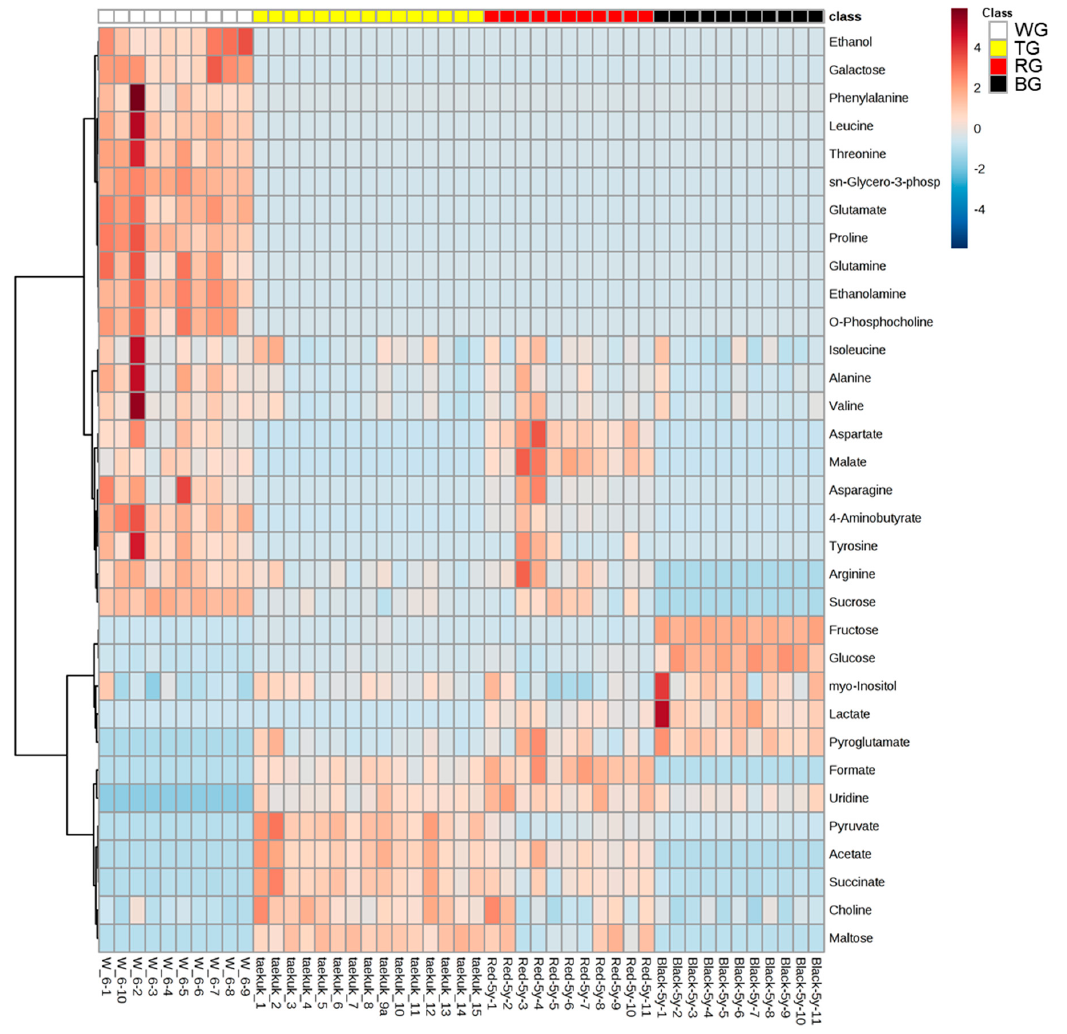
Figure 3. Heatmap of the quantified metabolites. WG, white ginseng; TG, tae-geuk ginseng; RG, red ginseng; BG, black ginseng.